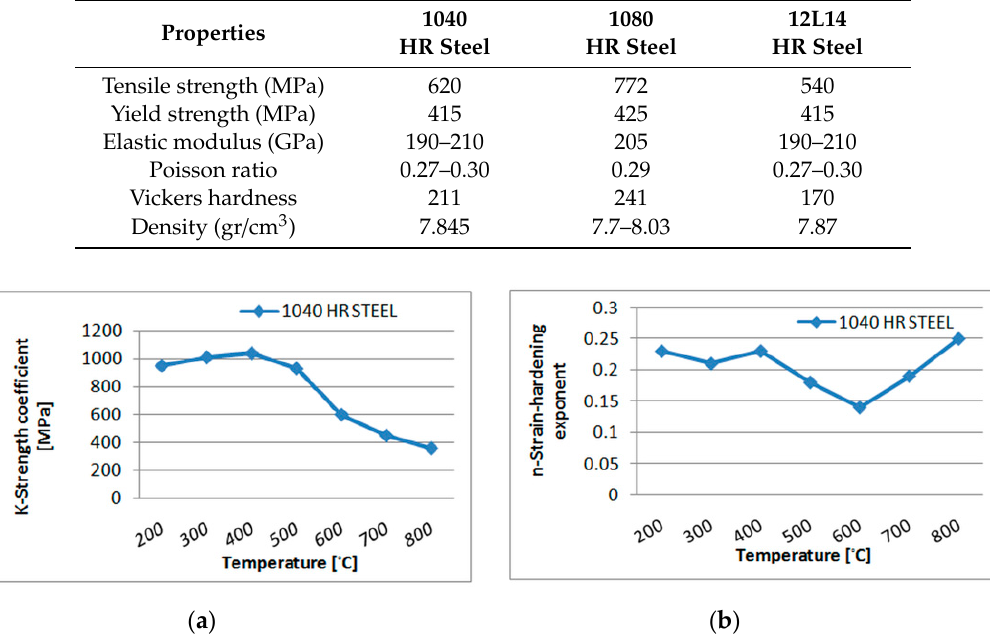
Figure 3. 1040 HR steel characteristics ( a ) K at different temperatures; ( b ) n at different temperatures.